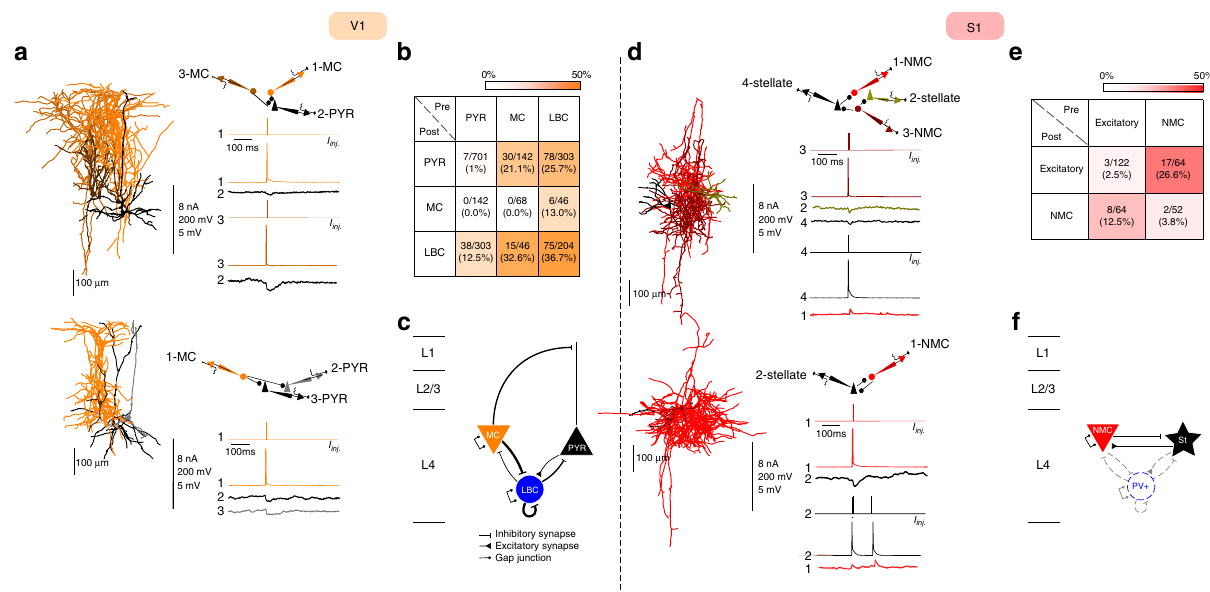
Fig. 5 Connectivity between excitatory and SOM + cells in L4 of V1 and S1. a Examples of simultaneous recordings from excitatory and SOM + neurons in V1 L4. Recorded neurons were close to each other (generally less than 150 μ m). Vertical scale bar indicates: amplitudes of injected currents in nA, amplitude of APs in mV and amplitude of uEPSPs or uIPSPs in mV. b Color-coded connectivity matrix shows the connection probability between cell types as a percentage of tested potential connections. Averages of uEPSPs and uIPSPs as well as PPRs are reported in Supplementary Fig. 9. For the connectivity involving LBCs, see also Supplementary Fig. 10. c Schematic of the local circuitry in L4 V1. For gap junctions, see Supplementary Fig. 8. Line thickness corresponds to connection probability. d – f The same for L4 S1. In the schematic ( f ), the connectivity rate involving PV + interneurons (mostly LBCs) is taken from Ma et al. 24 . All the PV + connections are shown with the same strength as that study used juvenile (P15) mice and so connection strengths are not directly comparable to the values obtained in our experiments. Regarding gap junctions between FS interneurons see also Galaretta et al. and Gibson et al.